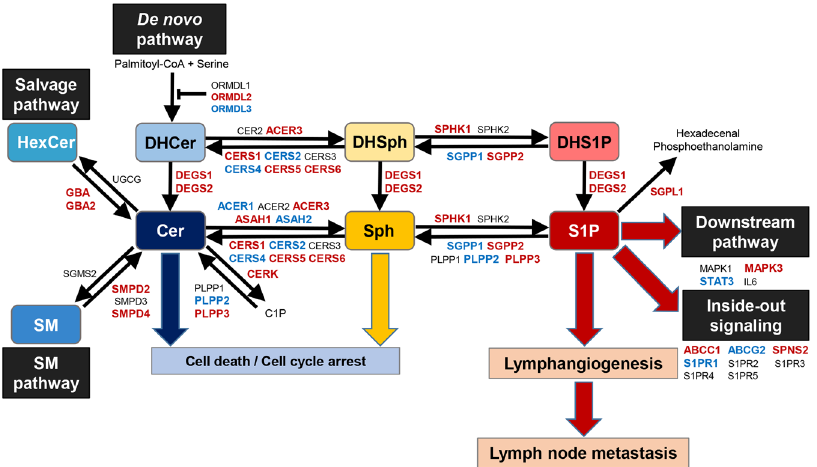
Figure 7. The dynamics of S1P- and ceramide-synthesis pathway. The gene expression levels of substrates with red capitals were increased in biliary tract cancer compared to normal biliary tract tissue, those with blue capitals were decreased in biliary tract cancer compared to normal biliary tract tissue, and those with black capitals were equivalent between them according to TCGA